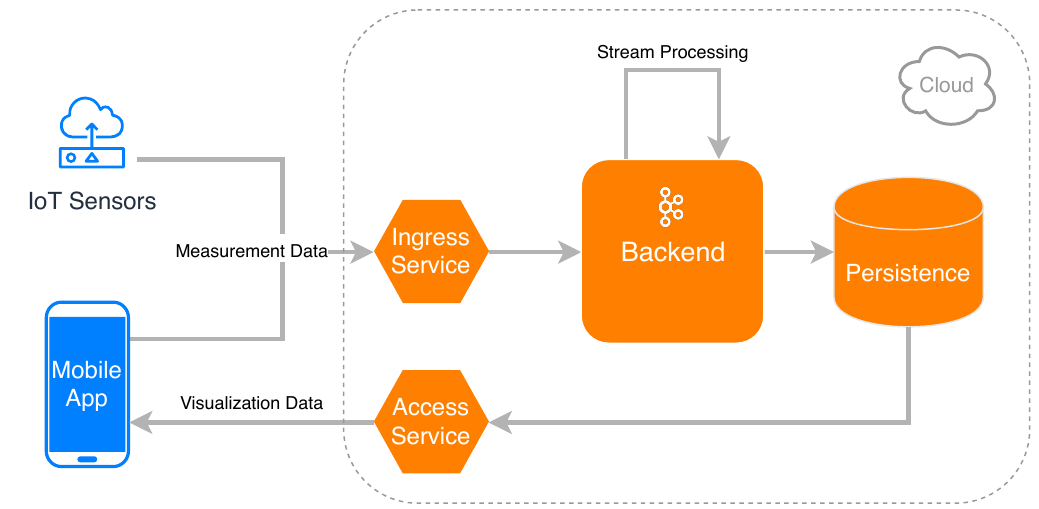
Figure 1. System design overview of the crowdsensing